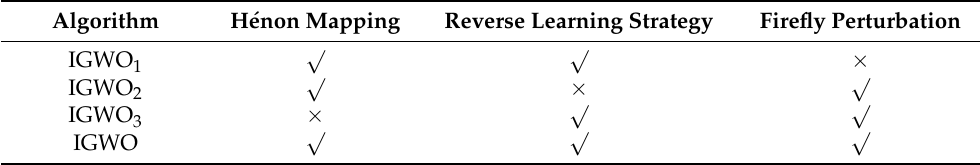
Figure 7. ACMD algorithm decomposition results.